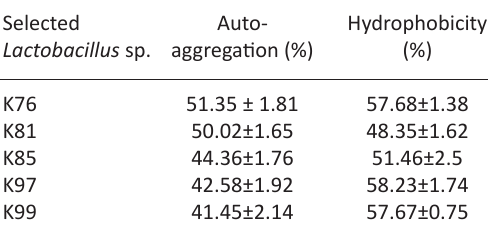
Table 3. Antagonistic activity of Lactobacillus mucosae (K76), L. fermentum (K81), L. fermentum (K85), L. reuteri (K97) and L. reuteri K99) and zone of inhibition (mm) against test pathogens. Error bars indicate ± standard deviation Isolates